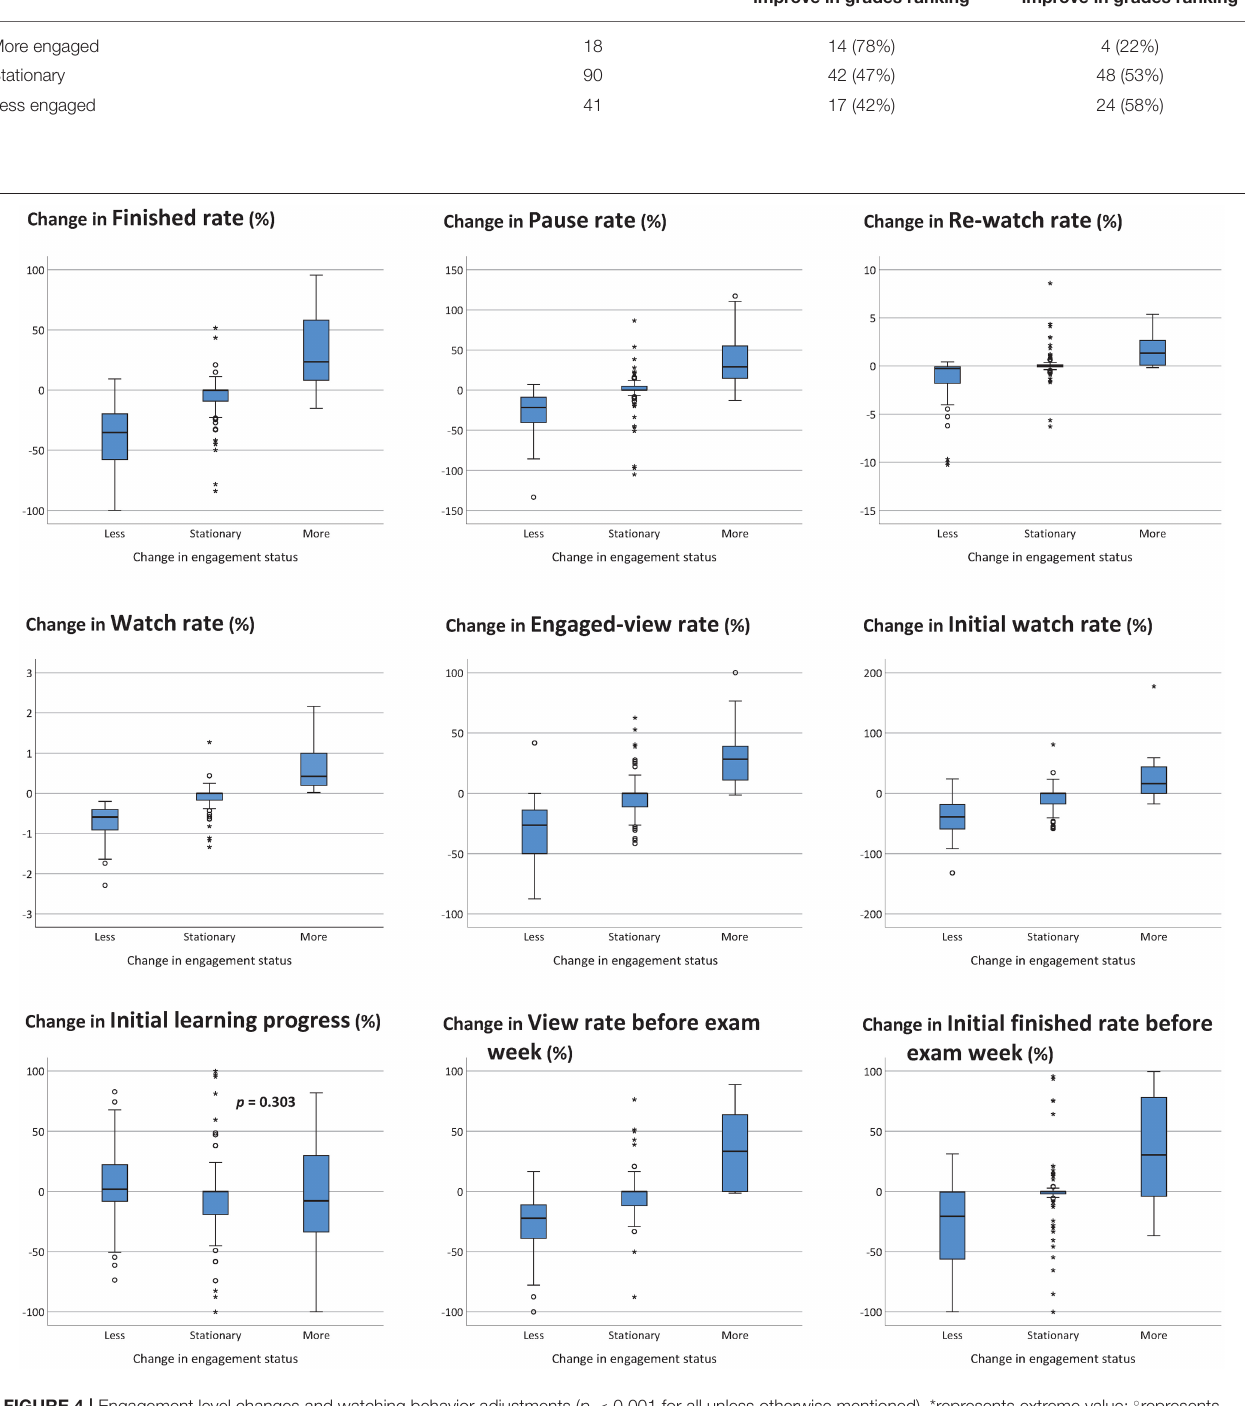
Frontiers in Medicine |